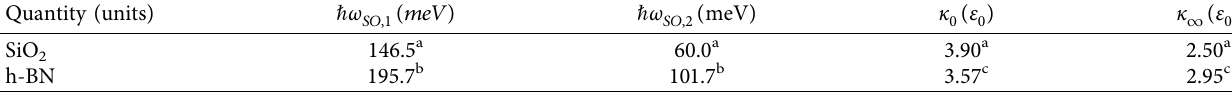
2 and h-BN substrates used in the computation.